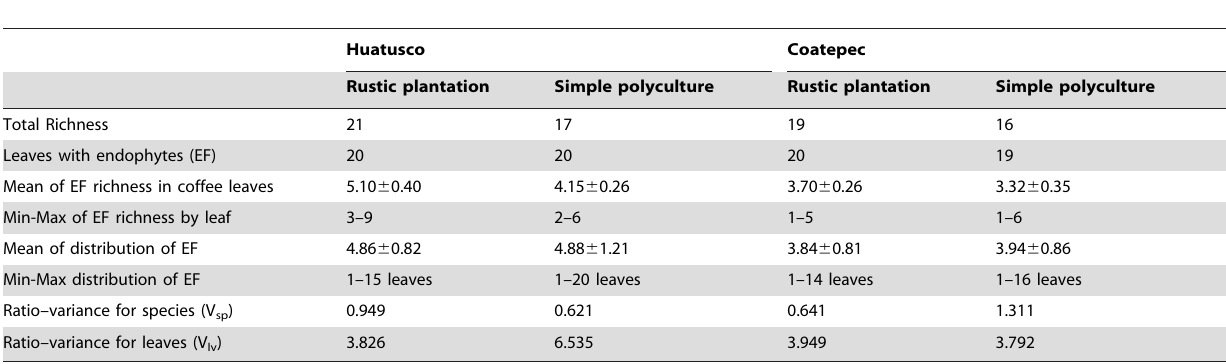
agroforestry systems (Fisher’s alpha: F =40.4381, p , 0.0001; Shannon’s diversity: F= 22.8818, p , 0.0001) and with the interaction between coffee region and agroforestry system (Fisher’s Table 3. Richness-distribution analysis of the endophytic fungi isolated from each coffee plantation.